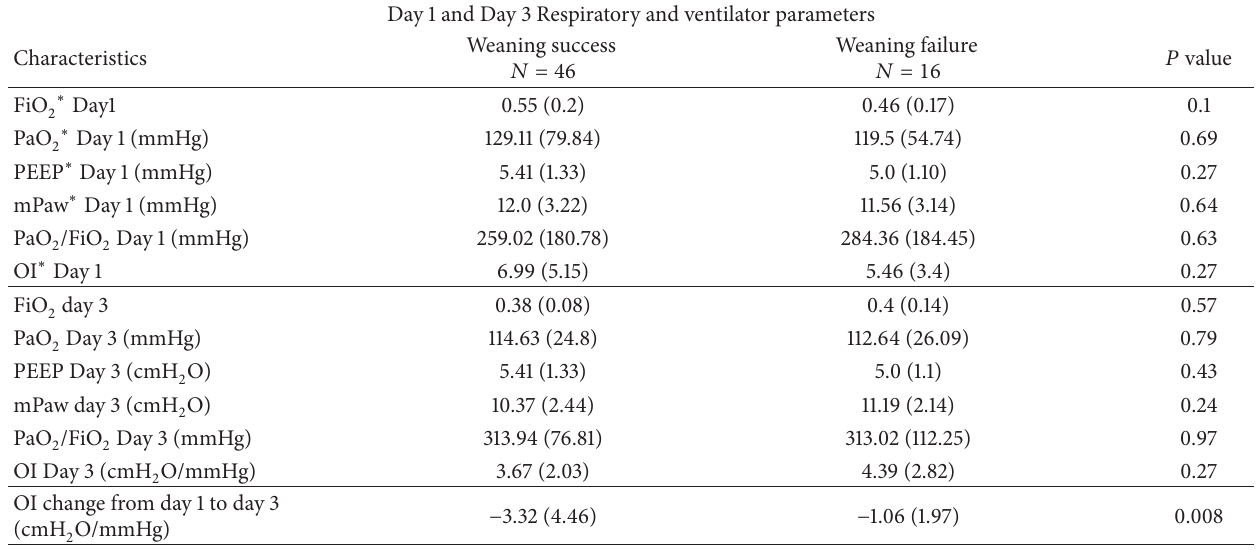
Table 8: Day 1 and day 3 respiratory and ventilator parameters of patients with different weaning outcomes # .